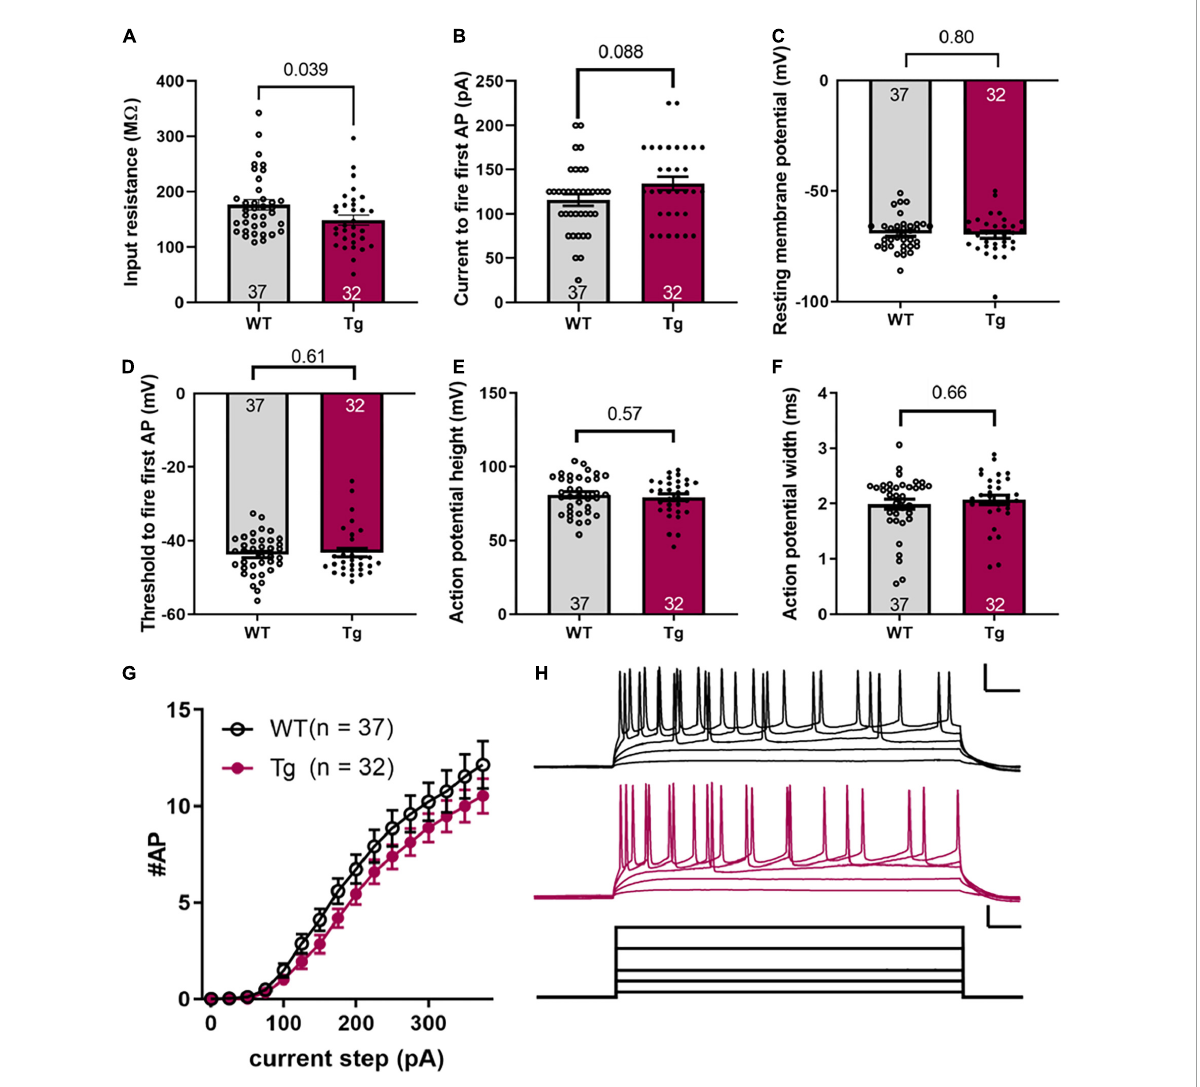
FIGURE2 Intrinsic excitability is not different between WT and Tg mice. (A) Input resistance, (B) current to fire the first action potential, (C) resting membrane potential, (D) threshold voltage to fire first action potential, (E) action potential height, (F) action potential width (FWHM), (G) number of action potentials fired for a given current step. (H) Representative data for a single WT and Tg mouse. Upper scale bars, 50 ms and 25 mV. Current scale bars, 50 ms and 100 pA. Error bars indicate ± SEM; the number of cells (N) is indicated at the bottom of each histogram; and, the p value is noted above the connecting line at the top (Student’s t -test or Mann–Whitney as mentioned in the text).